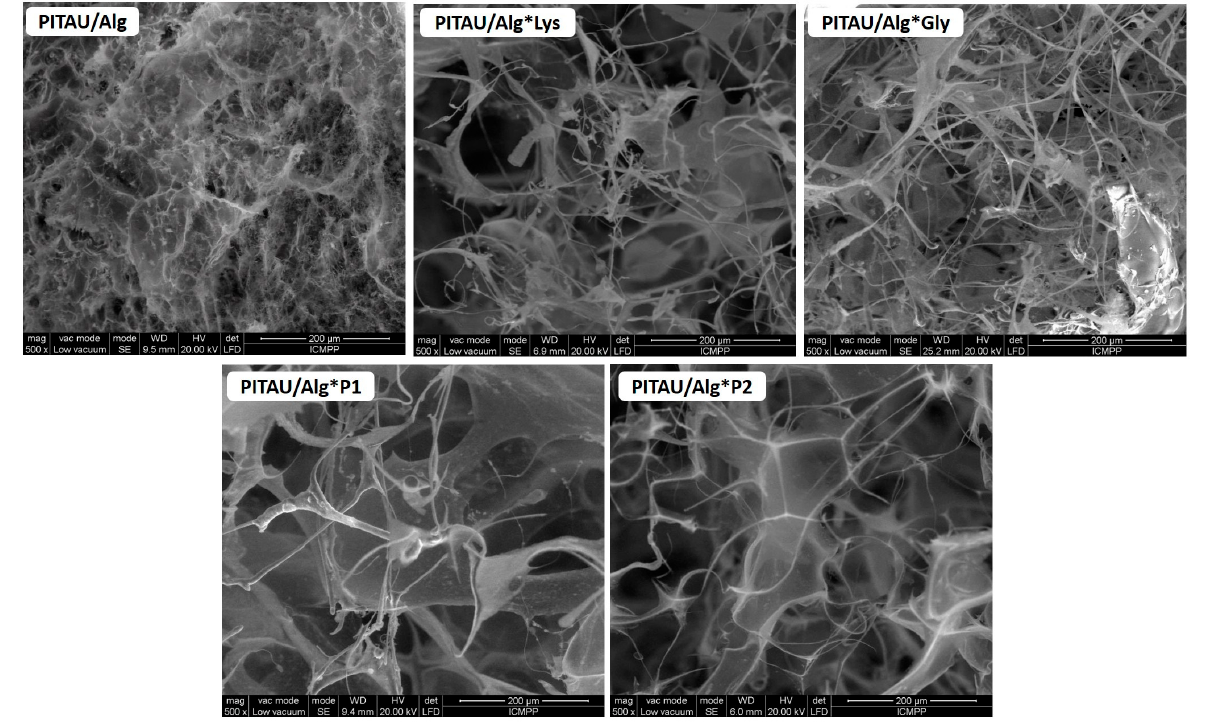
Figure 10. SEM microscopy of the PITAU/Alg and DN hydrogels.